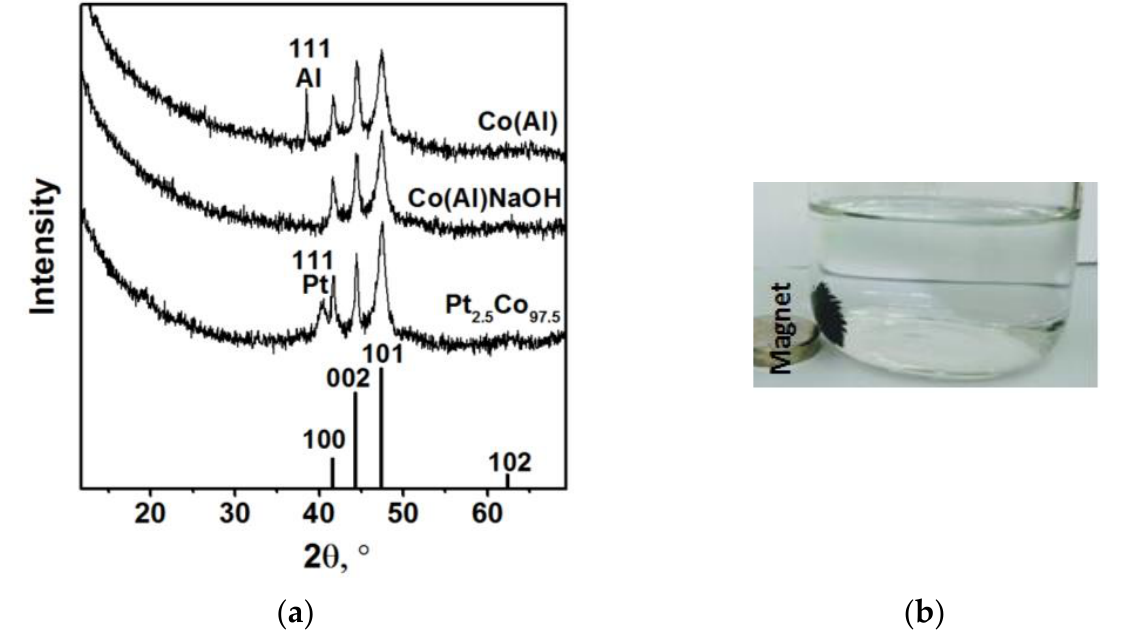
Figure 2. ( a ) XRD patterns of Co(Al), Co(Al)NaOH, and Pt 2.5 Co 97.5 and bar chart of the XRD peaks for metallic hcp Co (PDF card 05-727). Al—metallic aluminum (PDF card 04-0787); Pt—metallic platinum (PDF card 04-0802). ( b ) Photographic image of Co(Al) in the presence of an external magnet showing its magnetic properties. Table 1. XRD analysis data for initial Al and synthesized Co(Al), Co(Al)NaOH, and Pt 2.5 Co 97.5 cata- lysts.